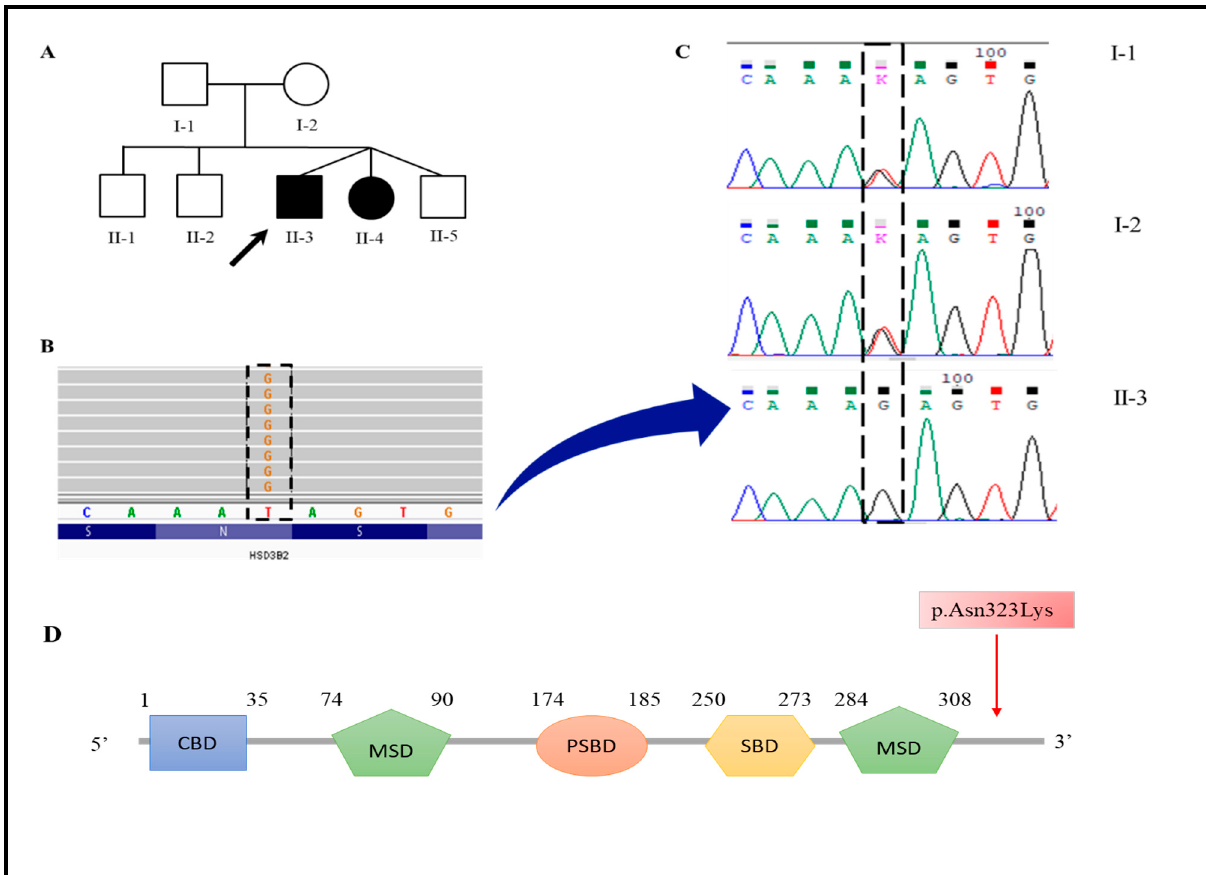
Figure 3. Pedigree, sequencing results and schematic presentation of HSD3B2 . ( A ) Pedigree of the family, the black arrow indicates the proband investigated through CES and array CGH. ( B ) Representative image of reads alignment showing the missense variant in the HSD3B2 gene (NM_000198.3:c.969T > G; p.Asn323Lys). ( C ) The variant c.969T > G was confirmed by Sanger sequencing. Segregation analysis revealed that the parents were heterozygous for the same variant. ( D ) Schematic diagram of the functional domains of HSD3B2, including cofactor binding domain (CBD), membrane-spanning domain (MSD), putative substrate-binding domain (PSBD) and sub- strate-binding domains (SBD). The red box shows the likely pathogenic variant detected in this study and located in the C-terminus.